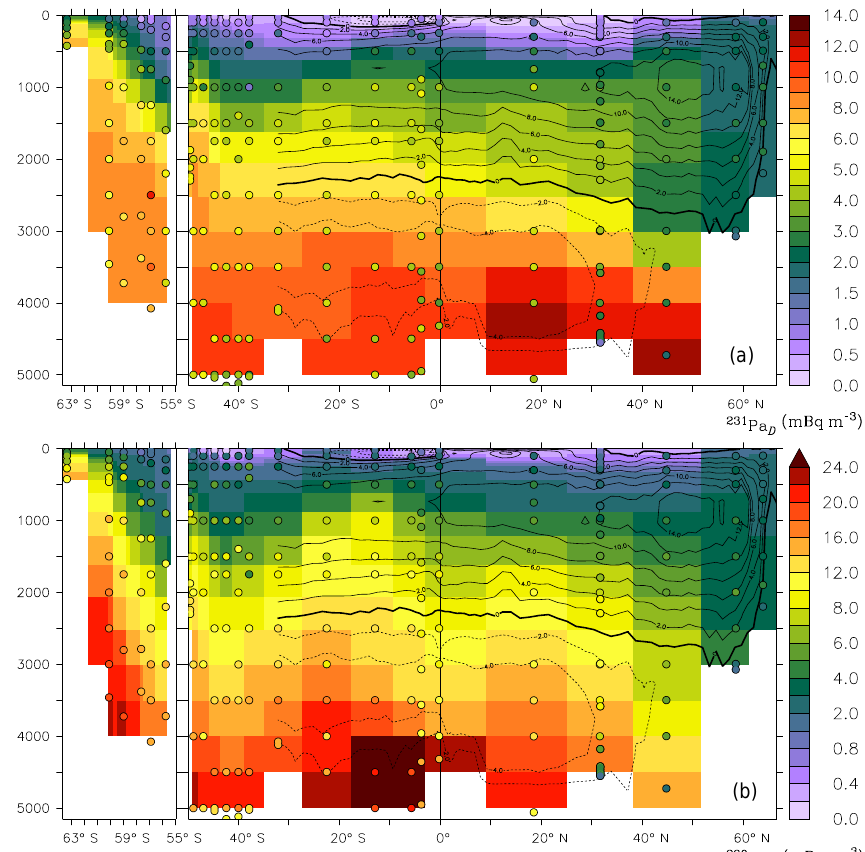
Figure 12. Dissolved protactinium-231 (a) and thorium-230 (b) at the Drake Passage (GIPY5) and western Atlantic (GA02) transects (mBqm − 3 ); observations as discs. The Atlantic OSF, in Sv, is superimposed as a